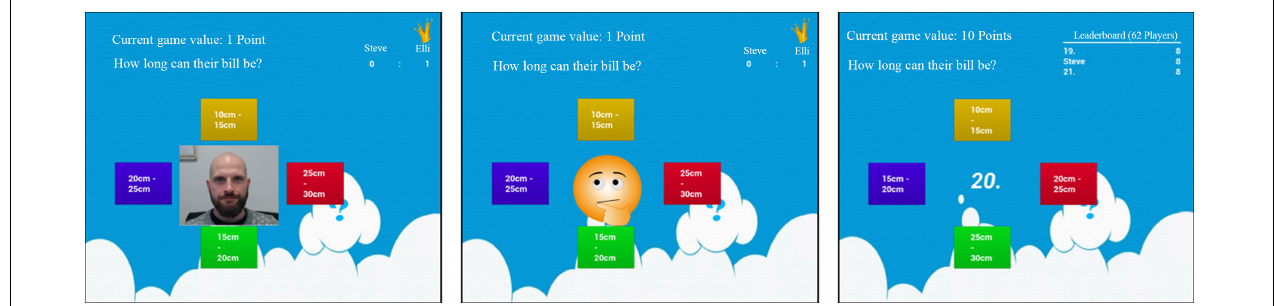
FIGURE 1 | Game variations (from left to right: HUMAN, AGENT,